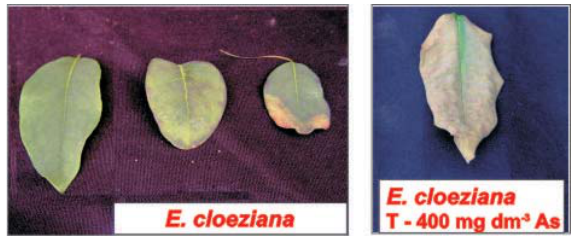
Figure 1. Visual toxicity symptoms in the basal leaves of E. cloeziana seedlings after eight days of growth in soil samples treated with 400 mg dm -3 of As.